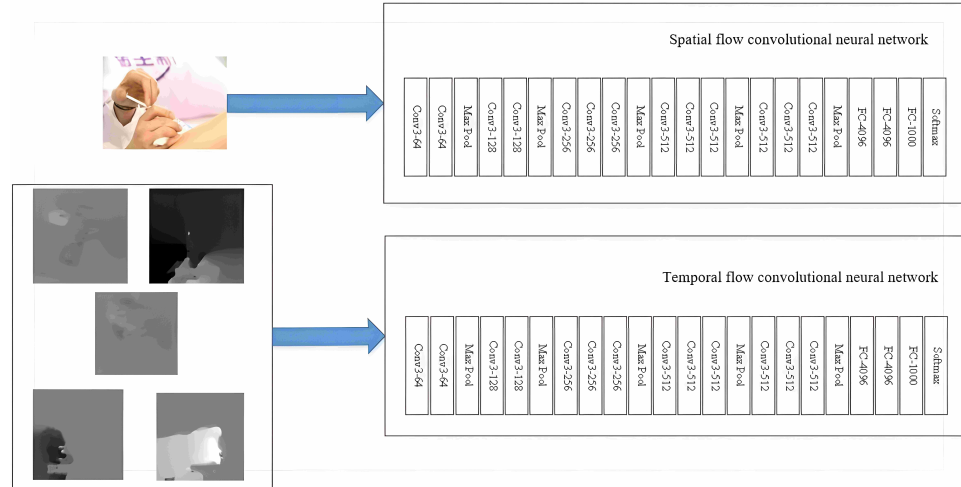
Figure 5. The presented two-stream network structure.